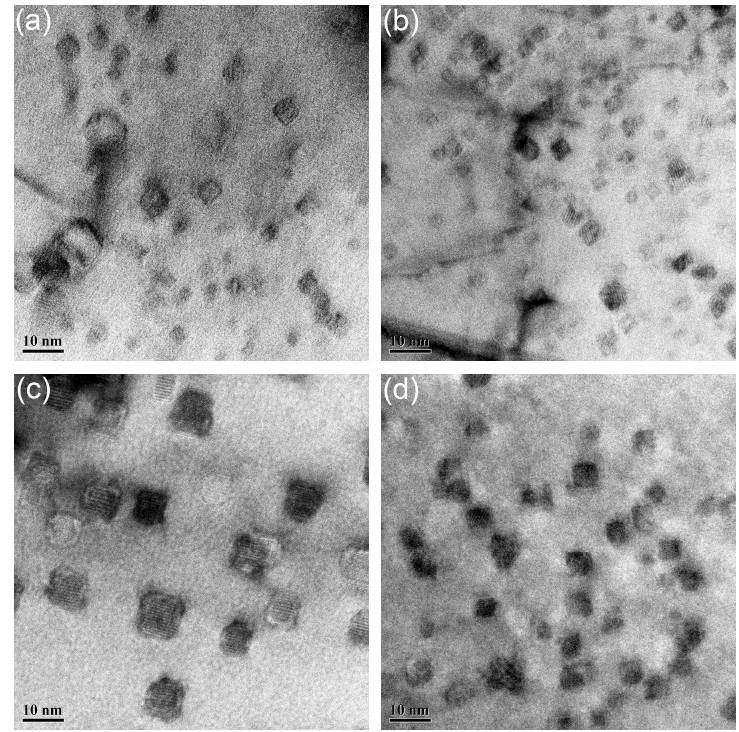
Figure 13. Distribution of nanoparticles in the samples deformed at 1200 °C with strain rate of ( a ) 1 s − 1 ; ( b ) 0.1 s − 1 ; ( c ) 0.01 s − 1 ; ( d ) 0.001 s − 1 . ( b ) 0.1 s − 1 ; ( c ) 0.01 s − 1 ; ( d ) 0.001 s − 1